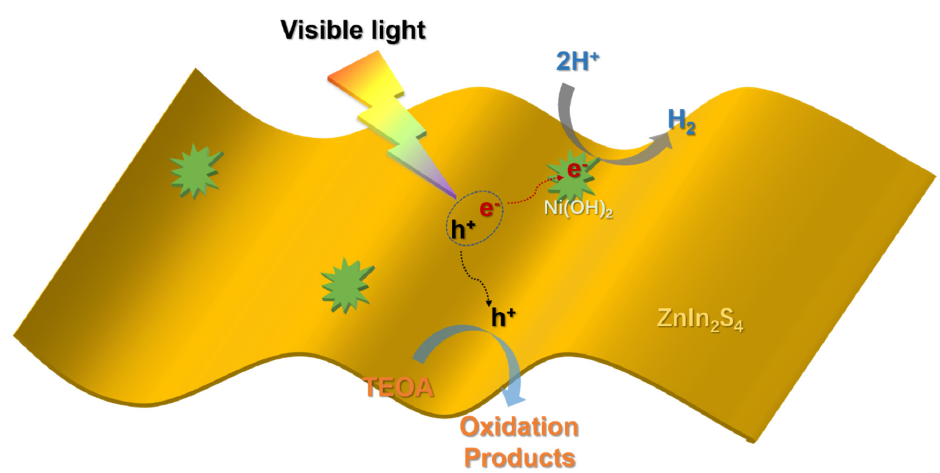
Table S3: Photocatalytic H 2 evolution results of some related works reported recently; Table S4: Detailed time-resolved transient PL decay fitting data of ZnIn 2 S 4 and 0.37 wt% Ni(OH) 2 /ZnIn 2 S 4 , respectively; Figure S1: XRD patterns of the samples after the preheating treatment before BET measurements; Figure S2: SEM image and enlarged SEM images of pure Ni(OH) 2 sheets (a,d), ZnIn 2 S